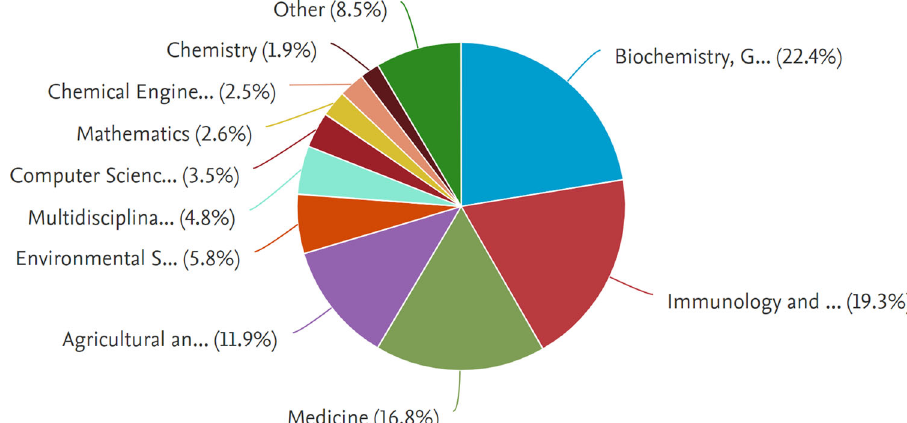
Fig. 2 Metagenomics studies by subject area. The data generated using Scopus database with the following speci fi cations: Search Date: February 2021. TITLE-ABS-KEY ( “ metagenomics ”